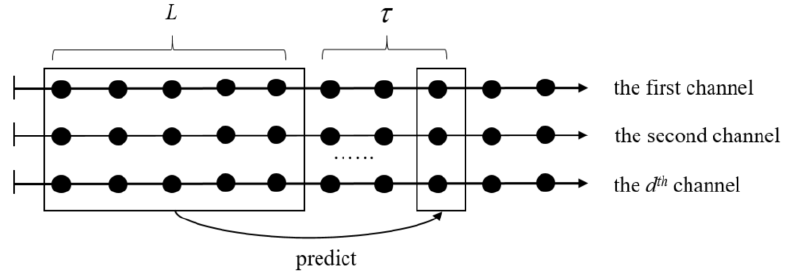
Figure 1. The principle of predicting the late reverberation using WPE. Where L is the prediction filter taps, τ is the delay coefficient, and d is the number of